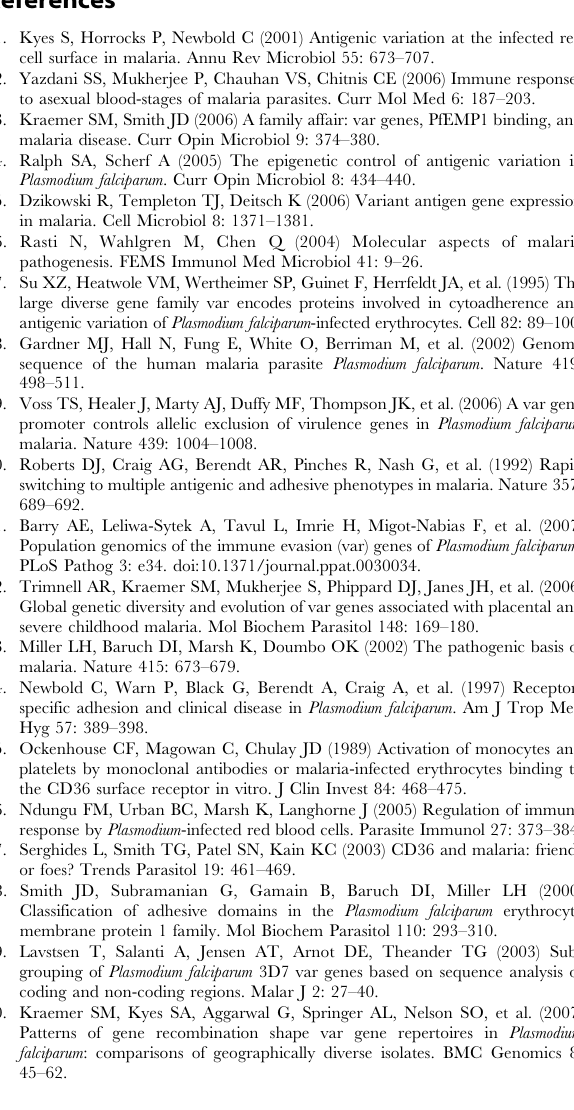
Figure S3 The CIDR2 b sequences from strain 3D7 aligned with the MC179 sequence. Note that the connecting helices region of CIDR2 b is less variable in length than in CIDR1 a sequences. Note that some CIDR2 b sequences lack cysteines 45 and 49 (MC179 numbering), for example, PF11_0007. In most domains, these cysteines make conserved disulfides with Cys 159 and Cys 168 or the analogous residues. The alignment was produced with ClustalW and colored in clustalx colors in the alignment editor/ viewer Jalview (http://www.jalview.org/). The MC179 helices are positioned according to the MC179 sequence (top line) and have colors and labels as described in the text. MAL8P1.207_CIDR2 b is not in the alignment as it is identical to PFD1235w_CIDR2 b . Figure S4 Plot of the lengths of the connecting helices of DBL1 a and CIDR1 a domains. The x -axis lists the 47 PfEMP1 genes from 3D7 that contain DBL1 a -CIDR1 a pairs, or head structures. The y -axis plots the lengths of the connecting helices of DBL1 a (red) and CIDR1 a (blue). The line (red) is a best-fit line to the DBL1 a data. The 47 data pairs have a Spearman’s rank-order correlation coefficient between them of 0.58 with p ,